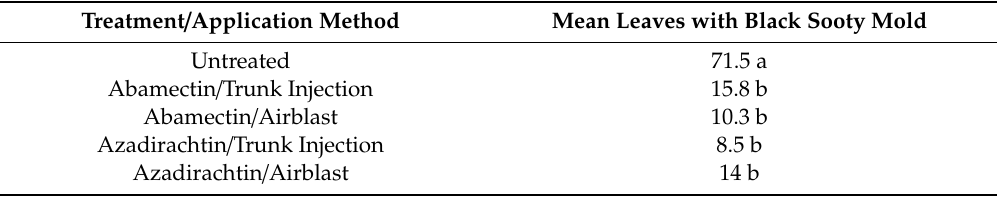
Table 2. Mean leaves with black sooty mold per treatment after conducting a 2 min visual count on 17 August 2017.